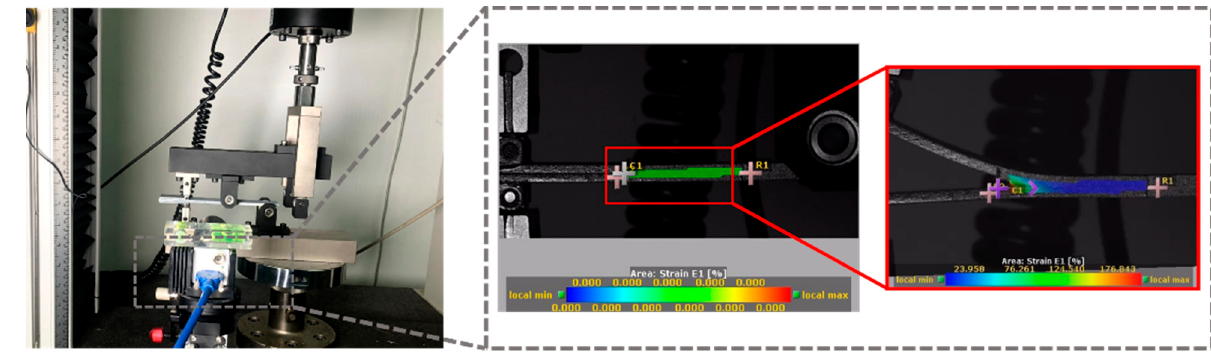
Figure 3. Crack measurement for fracture toughness of Mixed-mode.